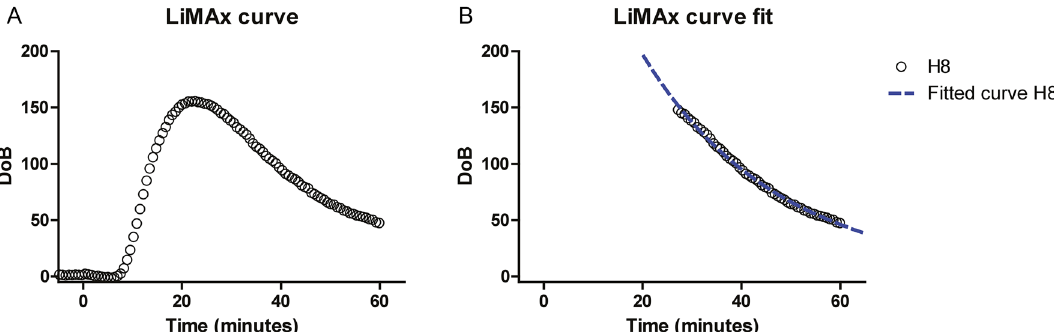
Figure 3. Feasibility of LiMAx testing during normothermic machine perfusion. Panel ( A ) displays the curve of the 13 CO 2 : 12 CO 2 ratio LiMAx curve as measured as a delta over baseline (DOB) during NMP. In the beginning, there is a flat line, which indicates the baseline, followed by the acceleration phase where the DoB increases until it reaches its maximum point (DoB max). Then, there is a decline of the DoB in the elimination phase. Panel ( B ) presents the fit of formula 4 on the elimination phase of the curve, which is fitted with an R 2 of 0.998. The K of the fitted formula was 3.633 × 10 –2 , which translates to a half-life time of 19 min.